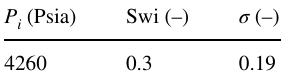
Table 10 Initial conditions of